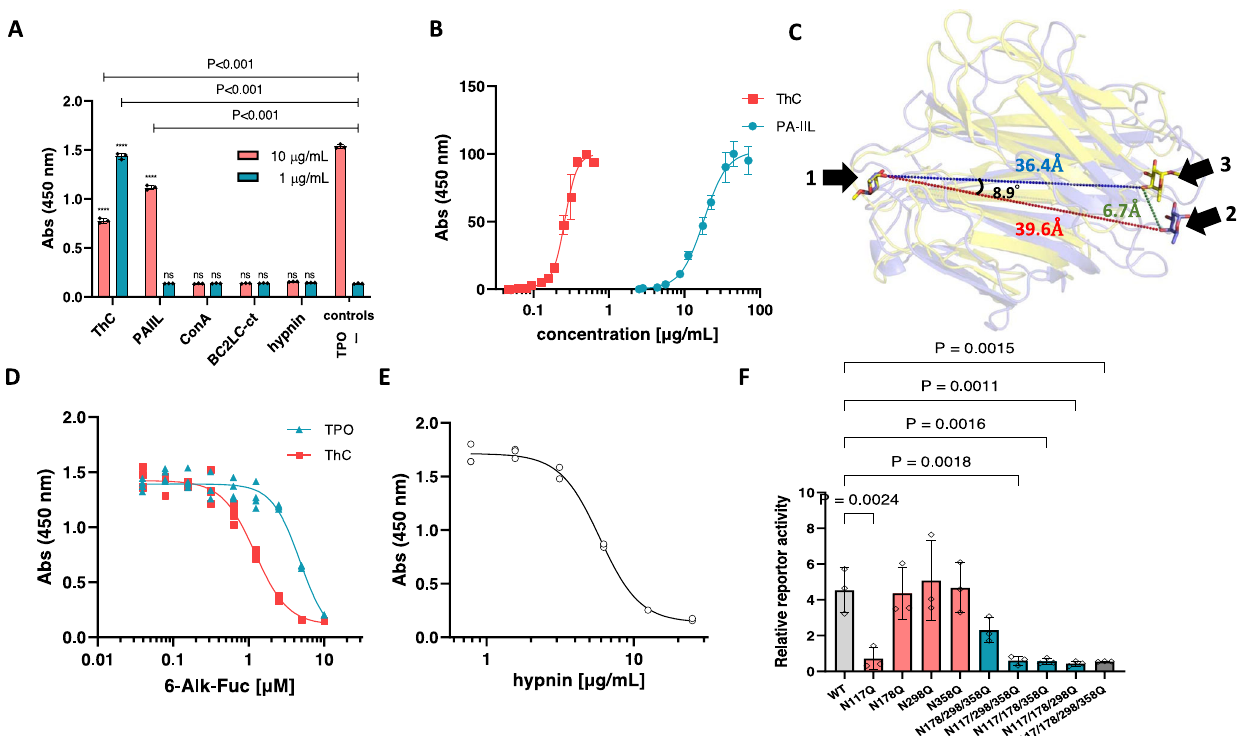
Fig. 4 | Involvement of the fucose moiety in ThC-dependent MPL activation. A Effect of lectins on the proliferation of Ba/F3-HuMpl cells: PA-IIL, a fucose/man- nose selective bacterial lectin with high homology to ThC; ConA, a mannose- speci fi c legume lectin; BC2L-C-CTD, mannose-selective bacterial lectin with high homology to ThC; hypnin, a core 1,6-fucosylated glycan-speci fi c algal lectin. TPO, 10ng/mL; (-), no agonist. Note that the cell proliferation was suppressed in the presence of 10 μ g/mL ThC presumably due to the suppression of cell proliferation by its agglutinating activity and to the interference of receptor dimerization by occupying a ligand-binding site on a receptor molecule. B Concentration depen- dency of Ba/F3-HuMpl cell proliferation induced by PA-IIL (EC 50 =18.1 μ g/mL, 95% CI of 16.7 – 19.7) and rThC. C Relative positions of two fucose molecules bound to the ThCdimerand PA-IILdimer.One of thetwofucose moleculesbound to eachis superimposed (fucose on the left). The other fucose molecule is shown as sticks. PurplerepresentsfucoseboundtoThC,andyellowrepresentsfucoseboundtoPA- IIL. The numbers represent the distance between O4 atoms (red: between two